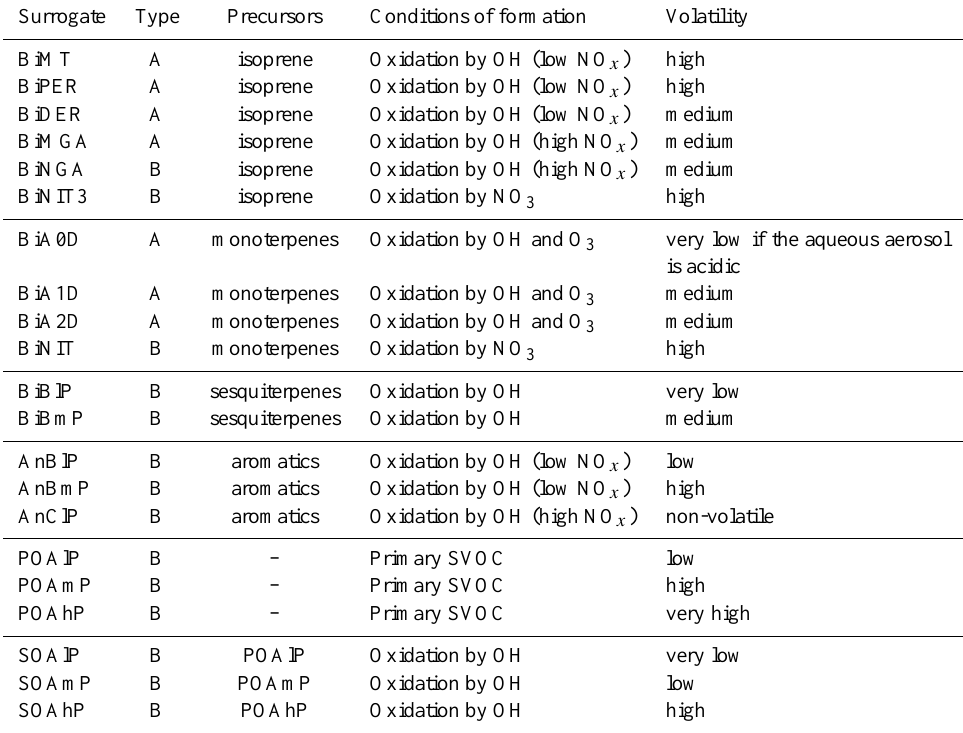
Table 4. Description of the H 2 O surrogate SOA species. Volatility is very low for compounds with K p > 100, low for compounds with 100 ≥ K p > 1, medium for compounds with 1 ≥ K p > 0.1, high for compounds with 0.1 ≥ K p > 0.01 and very high for compounds with K p ≤ 0.01. A and B species are, respectively, hydrophilic and hydrophobic